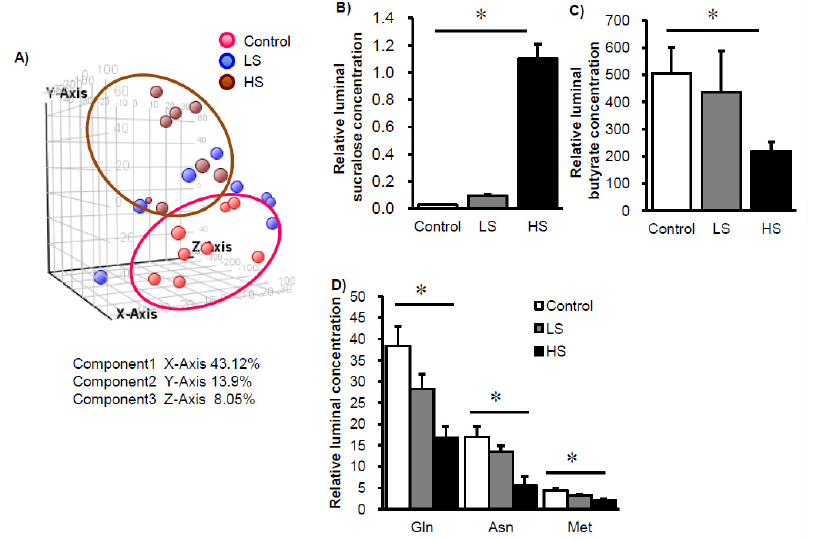
Figure 3. Changes in luminal metabolism in mice fed sucralose. Principle component analysis of 82 luminal metabolites in mice fed sucralose ( A ). Changes in relative concentration of sucralose ( B ), butyrate ( C ), and specific amino acids ( D ) in mice fed sucralose for 8 weeks. Data represent mean ± S.E. ( n = 8). * Concentration-dependent effects were observed by regression analysis, p < 0.05. LS: low sucralose (1.5 mg/kg BW/day), HS: high sucralose (15 mg/kg